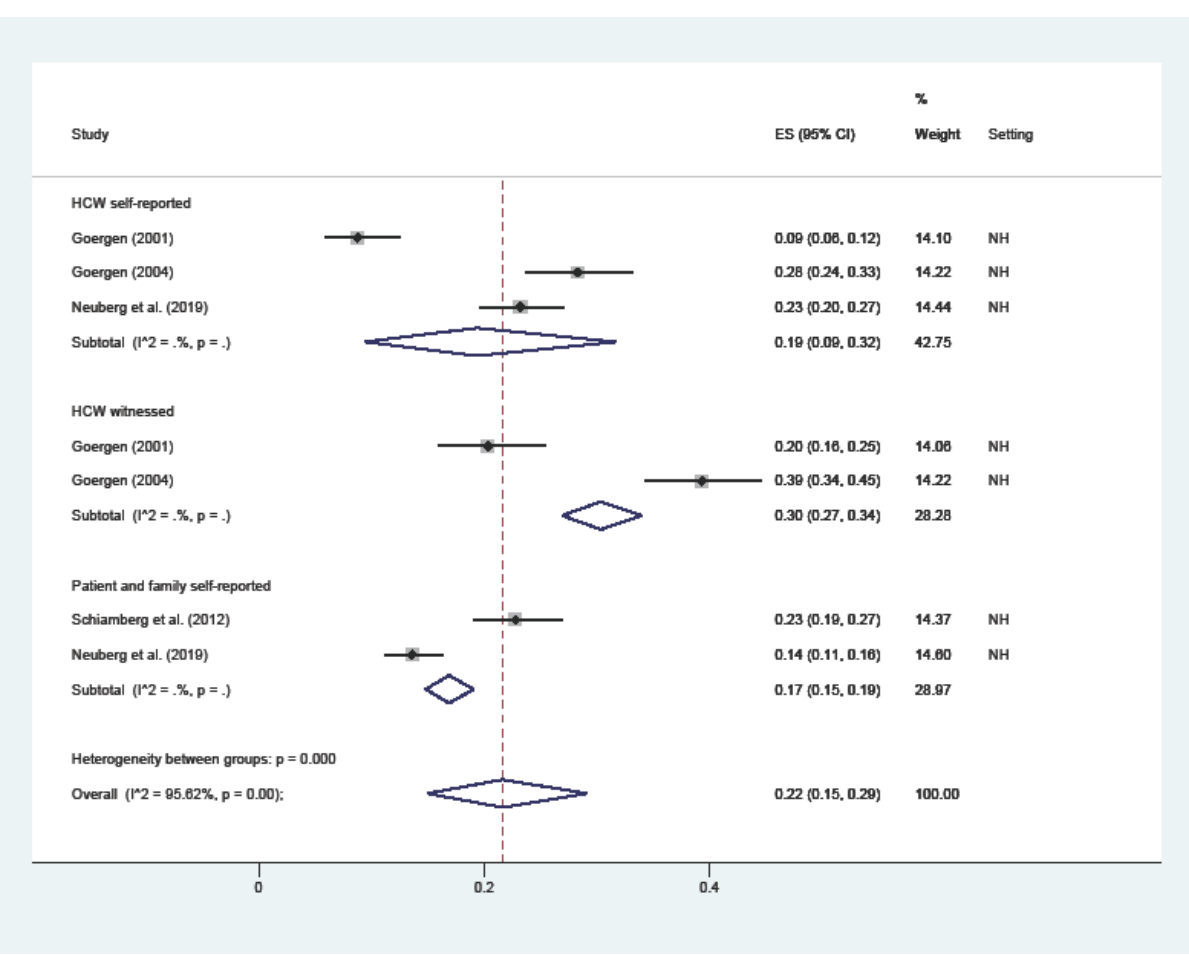
Figure 3. Forest plot of the prevalence of physical restraint in LTC. Subgroup meta-analyses by (Healthcare workers (HCW) self-reported, HCW witnessed, or patient and family self-reported). NH: nursing home; HC: home care.